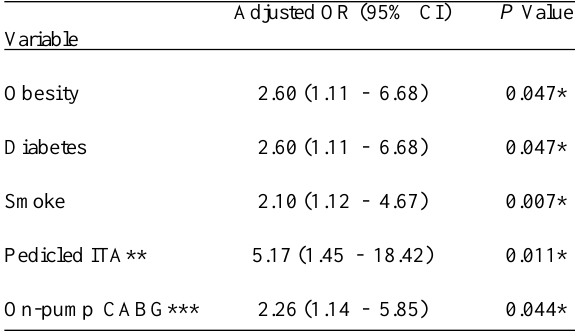
Table 4. Multivariate analysis by logistic